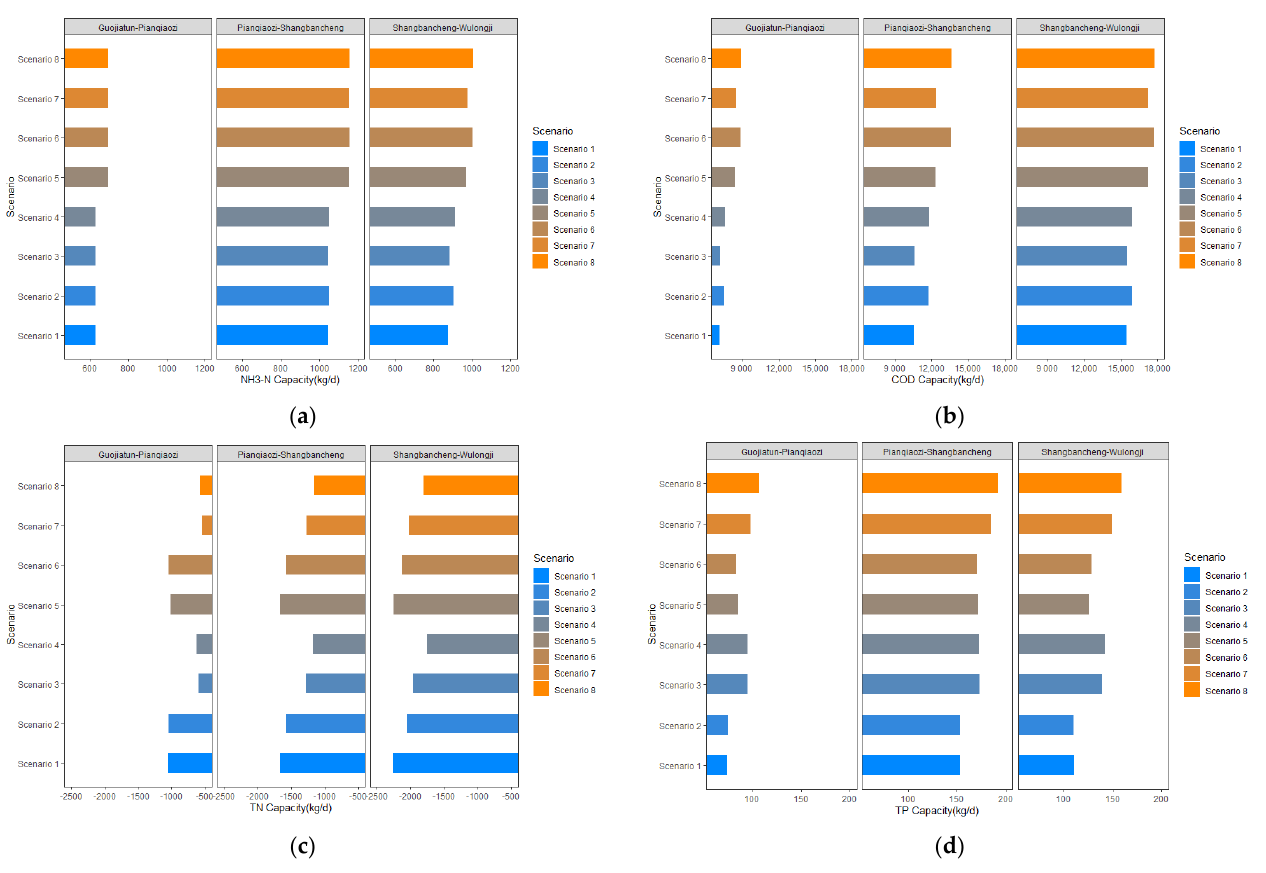
Figure 6. Change in NH 3 -N ( a ), COD ( b ), TN ( c ), and TP ( d ) capacity.